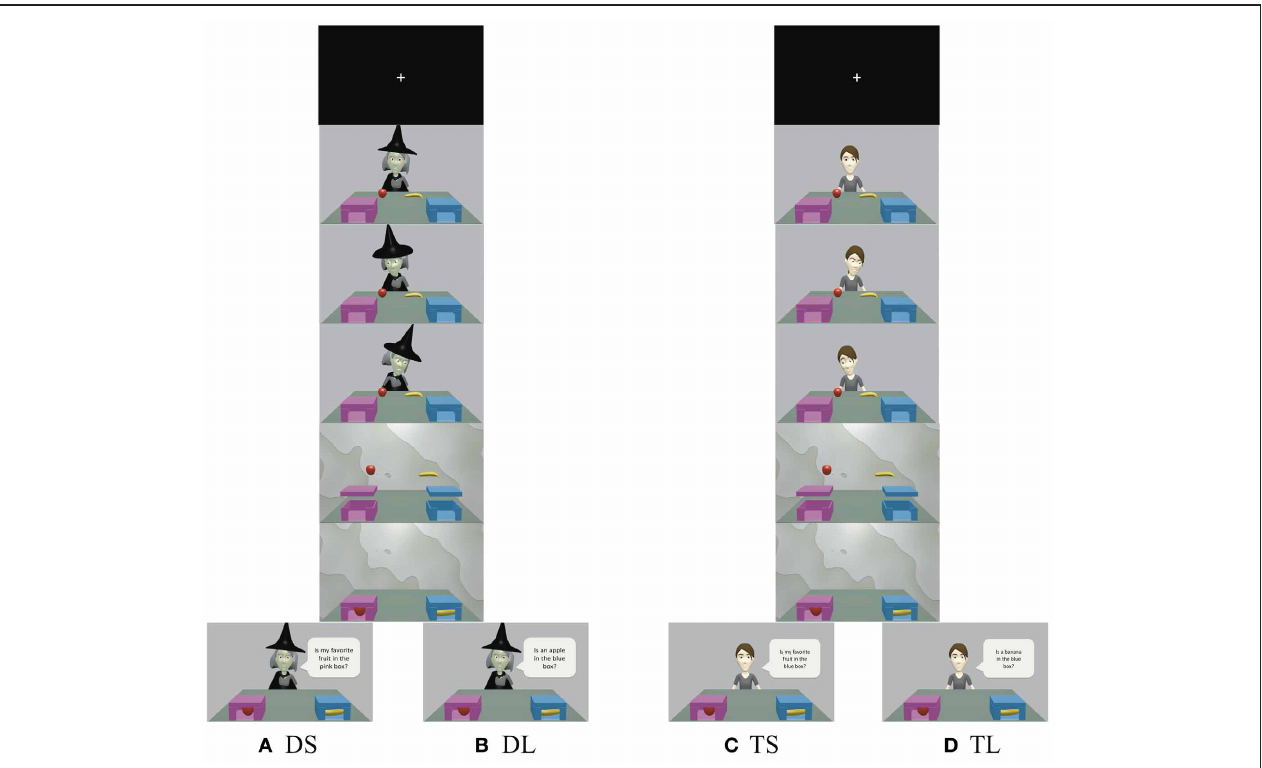
witch. Under the social conditions (DS and TS), protagonists asked about the location of their liked or disliked fruit. On the other hand, under the less-social conditions (DL and TL), protagonists asked about the location of a certain fruit. See the Materials and Methods section for additional